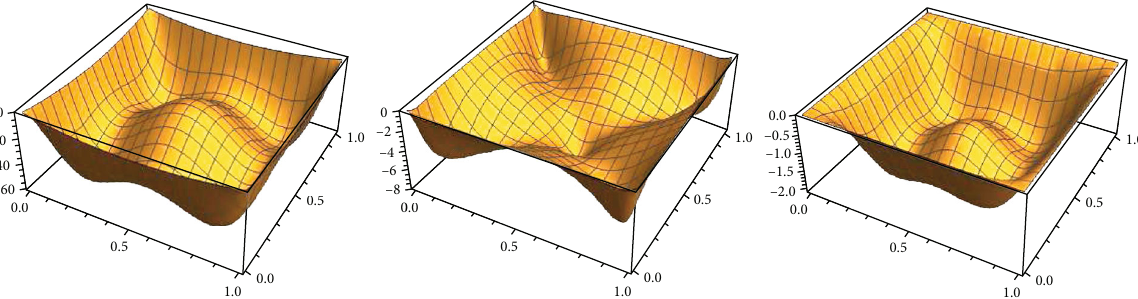
ð u , v Þ of the mean curvature H 0